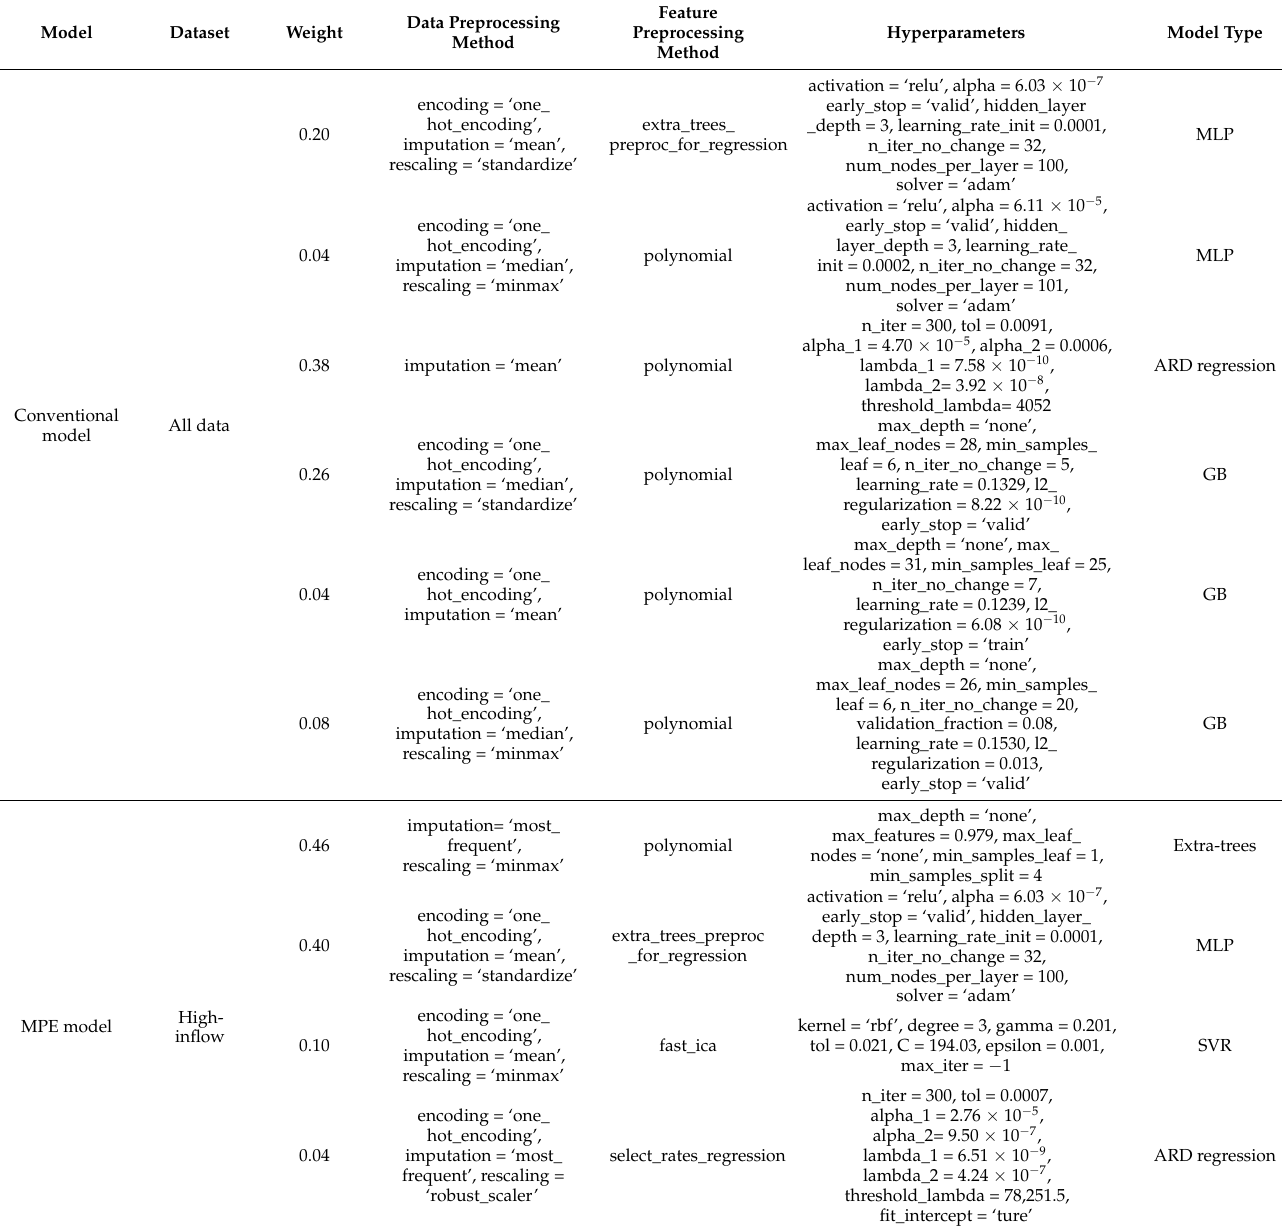
Table 2. Ensemble results of AS using conventional and combined